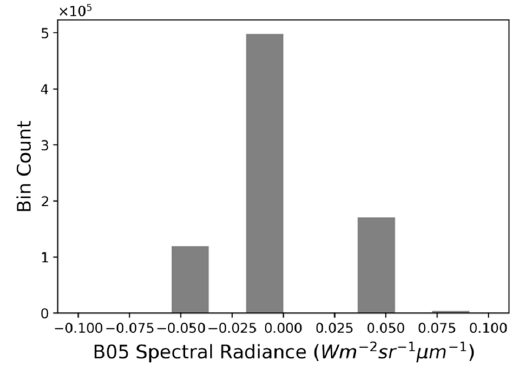
Figure A7. Spectral radiance distribution of nonthermal anomaly containing AHI B05 (1.6 µm) pixels for 25 September 2015 for the region shown in Figure A8.